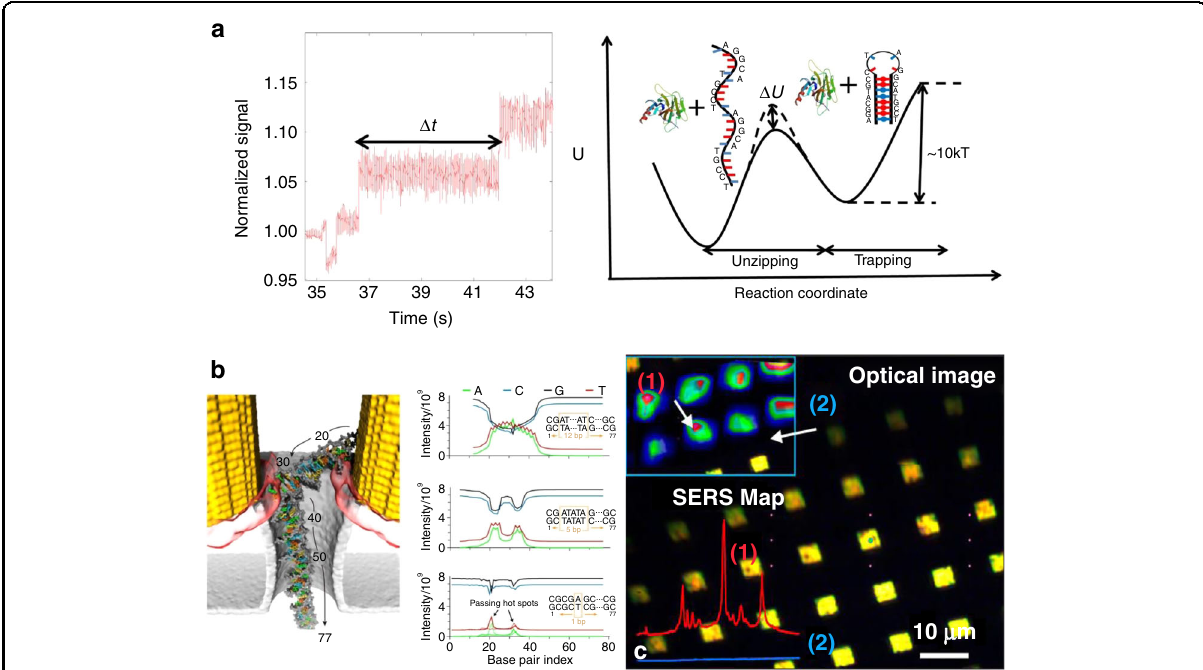
Fig. 16 Sensing and imaging applications of plasmonic traps. a Suppression of DNA hairpin unzipping by the tumour suppressor protein p53. Left: Wild-type p53 suppresses unzipping of the DNA hairpin for a delay of ~10 s. Right: Energy reaction diagram showing an increased energy barrier Δ U equivalent to the binding energy Δ G of p53 and DNA. b SERS detection of the DNA sequence. Left: Typical conformation of dsDNA trapped by plasmonic hotspots; the base pairs are numbered in ascending order from the trailing to the leading end of the molecule. Right: SERS signals from a poly(AT) block in the poly(CG) background. c SERS imaging of plasmonically trapped molecules in a three-dimensional plasmonic cavity. a Adapted with permission from ref. 233 , copyright 2014 Optical Society of America. b Adapted with permission from ref. 249 , Copyright 2015, American Chemical Society. c Adapted with permission from ref. 310 , Copyright 2015, American Chemical